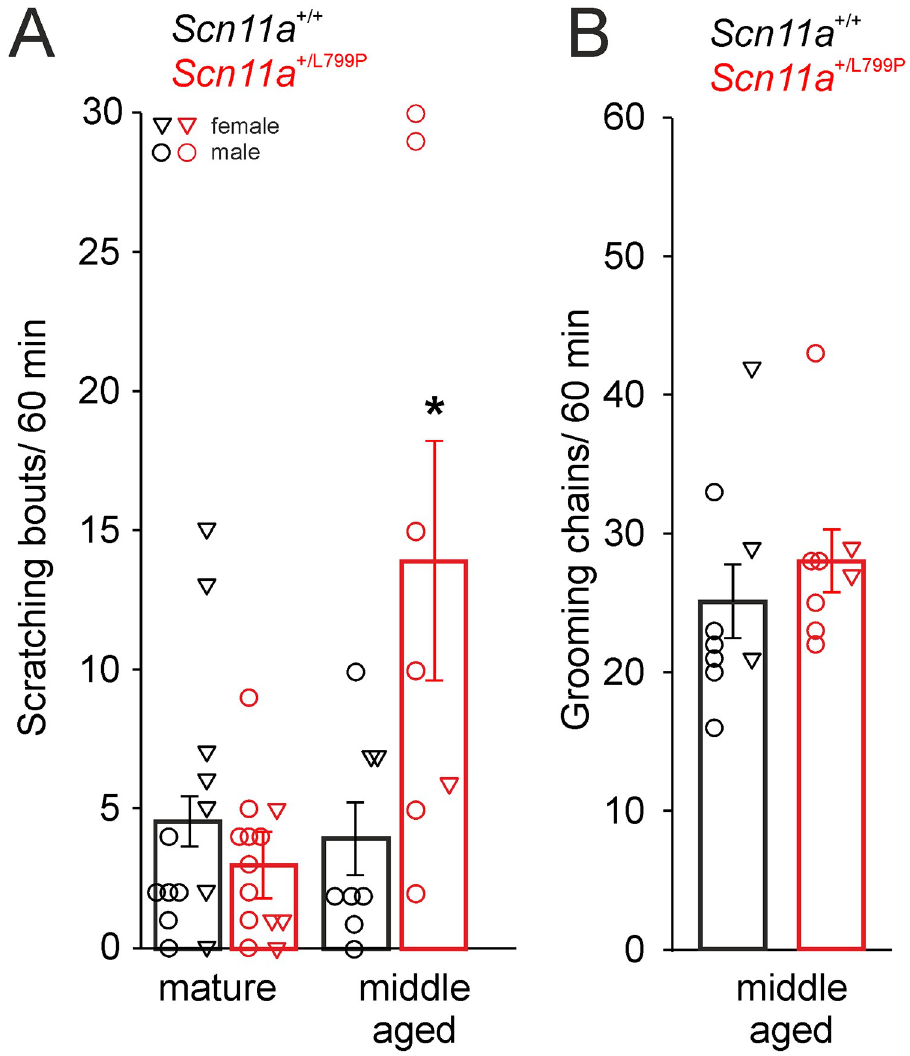
Fig 1. Quantification of scratching and grooming behavior of Scn11a +/+ and Scn11a +/L799P mice. (A) Middle aged (9–12 months) but not mature adult (3–5 months) Scn11a +/L799P mice showed enhanced numbers of scratching bouts (n = 7–13 per group). (B) No differences in the number of grooming chains were observed between both genotypes (n = 8–9 per group). Triangles indicate values of individual female mice, circles indicate values of individual male mice. Values are mean ± SEM. � p <